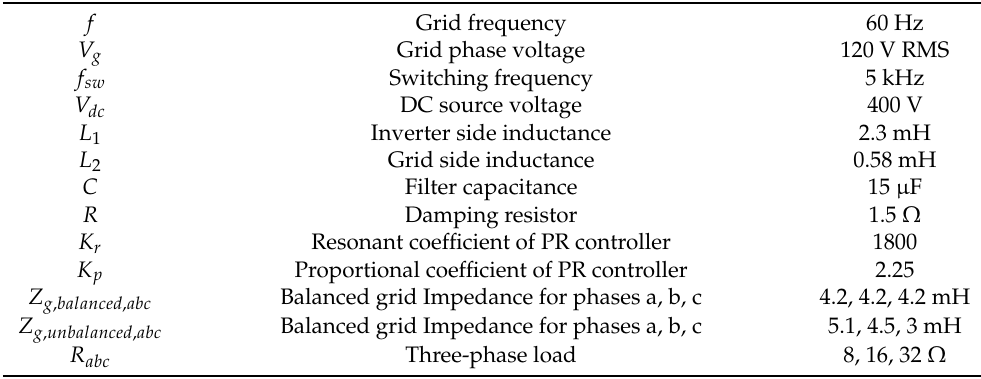
Table 1. System parameters.